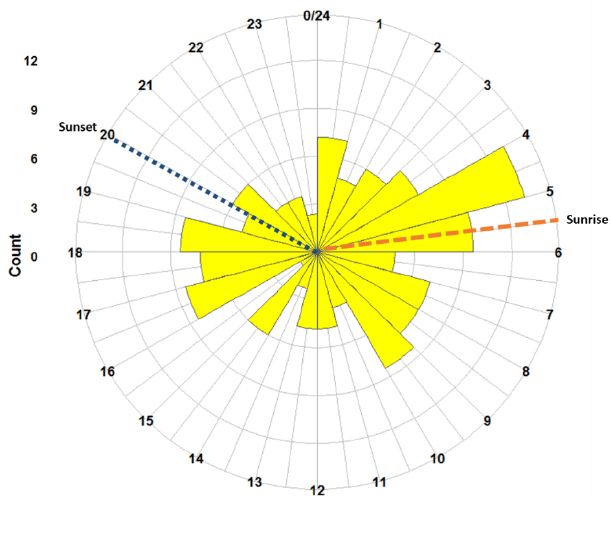
Fig. 6 . Diel variation (hrs, local time) of postbreeding departure times of Common Terns ( Sterna hirundo ; n = 120) from western North Atlantic study area during 2013. Dashed lines show local times of sunrise (orange) and sunset (blue).